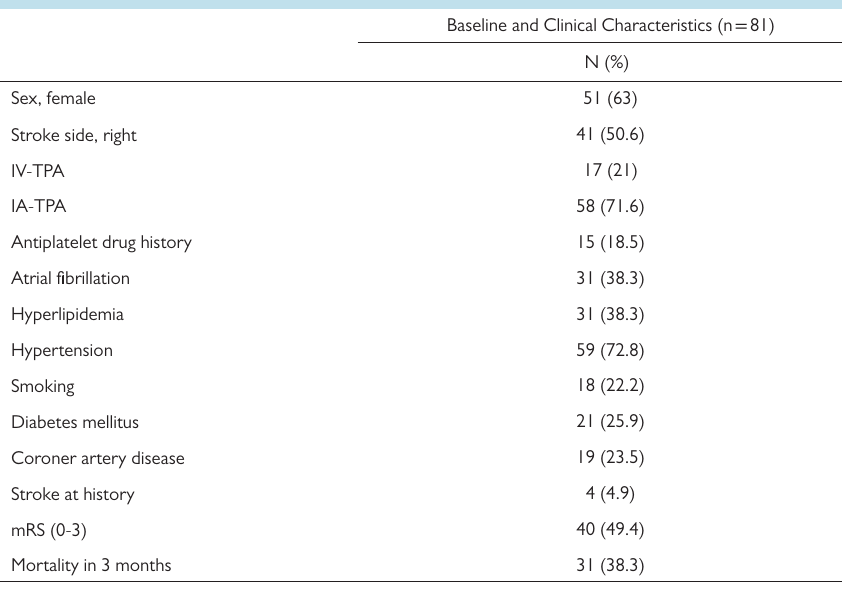
Table 1. Baseline and Clinical Characteristics of All Patients